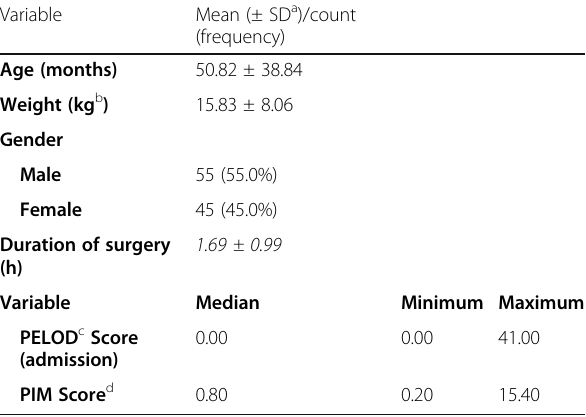
Table 1 Patients ’ demographic data. Data presented as mean ± standard deviation (SD), count, and